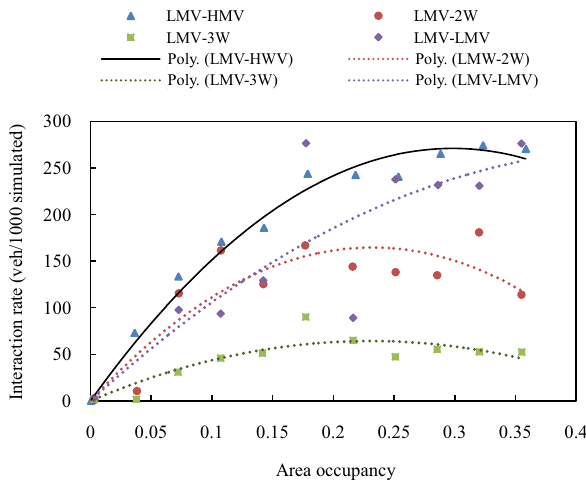
Fig. 15 Simulated interaction rates between LMV and different vehicle types for different values of area occupancies